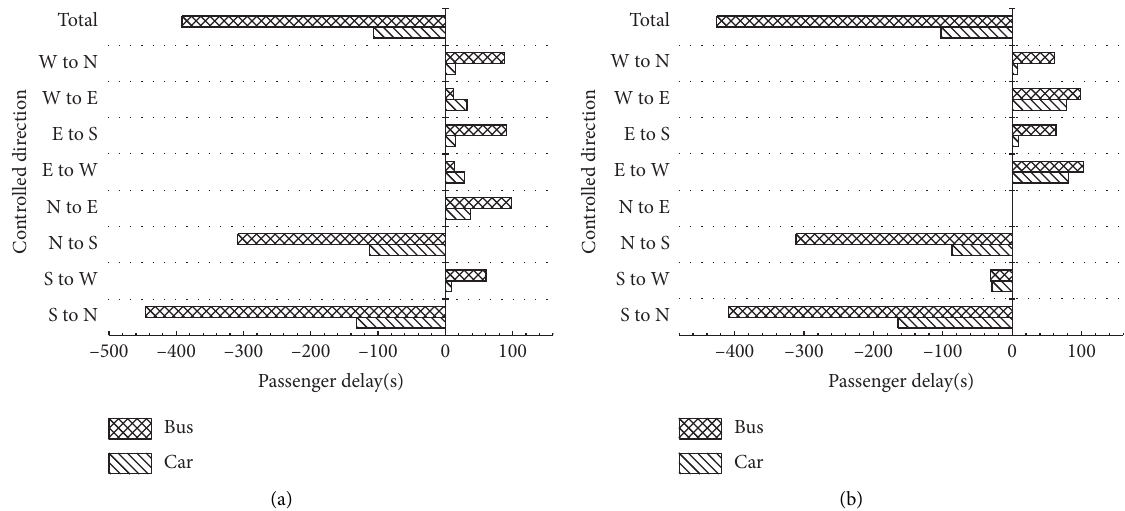
Figure 7: Comparison of the changes of the total passenger delay at the test intersections. (a) Huizhou Avenue and Ziyun Road intersection. (b) Huizhou Avenue and Jinxiu Avenue intersection.